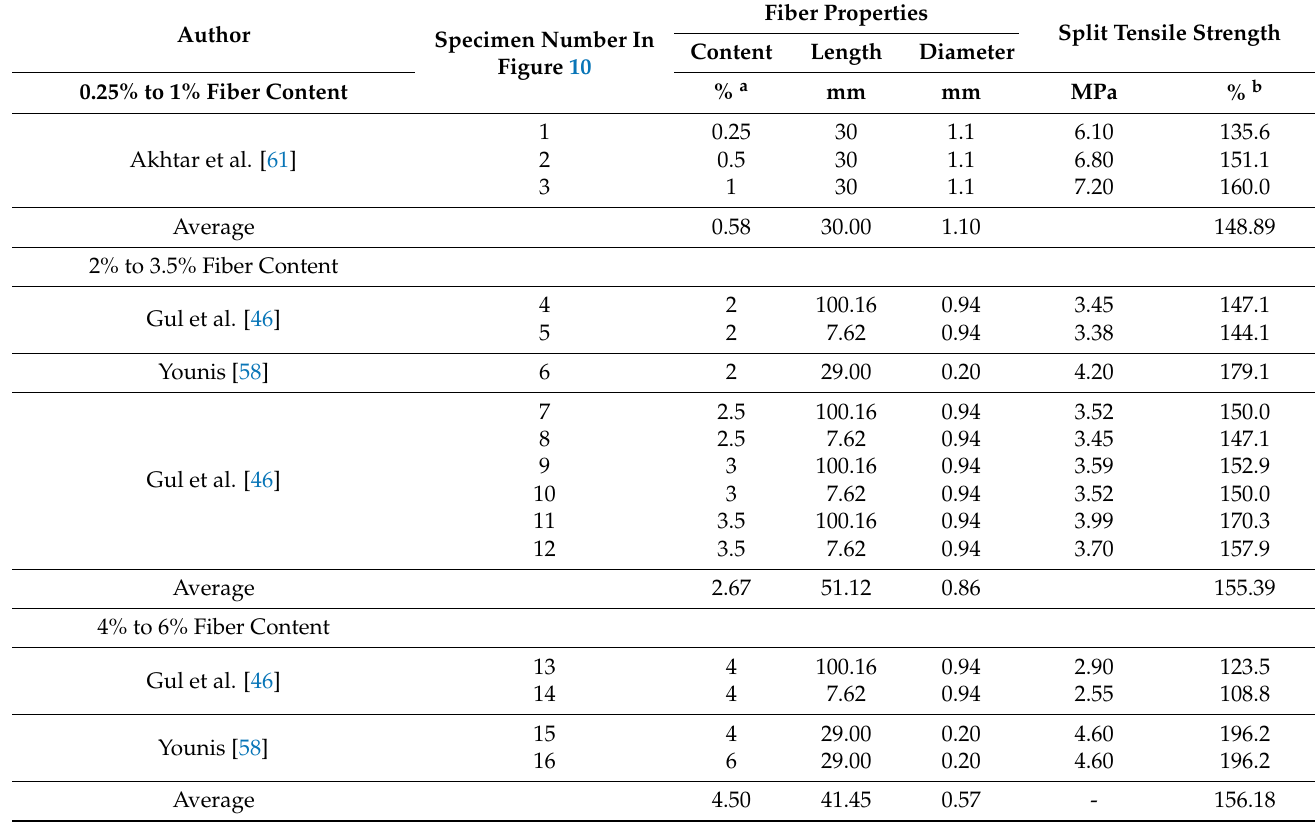
Table 7. Results of split tensile strength’s percent comparison and fiber properties of the concrete incorporating RSF by its weight